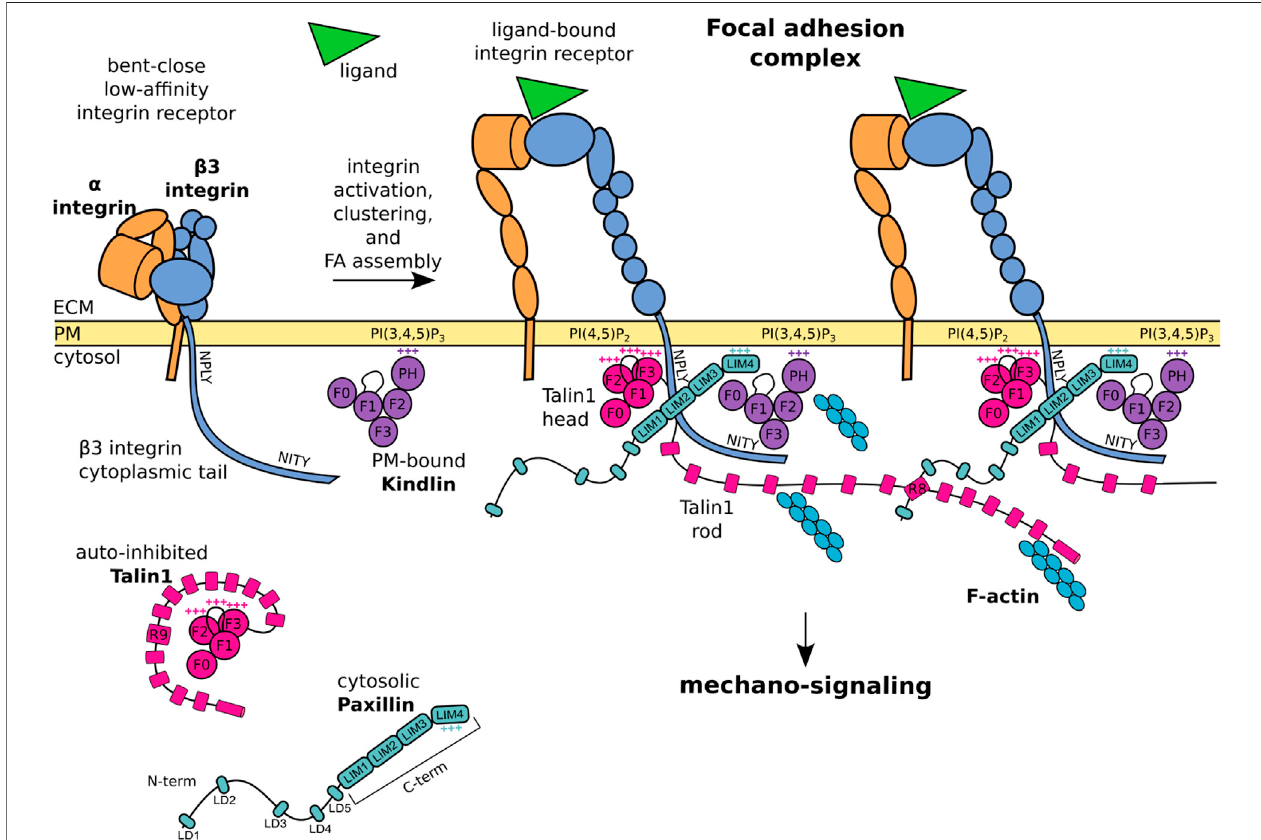
FIGURE 1 | Schematic representation of core FA proteins and their interactions. The β 3 integrin subunit is composed of an extracellular domain, a transmembrane domain, and a C-terminal cytoplasmic tail presenting the membrane proximal NPLY talin-binding and membrane distal NITY kindlin-binding sites. The heterodimericintegrinreceptorinabent-closelow-af fi nityconformation(left)switchestoanextended-openhigh-af fi nitystateandbindsligandsandintracellularproteins (right). Talin1 consists of a globular head, an unstructured linker, and a C-terminal rod domain which intramolecularly interacts with the head domain to keep cytosolic talin1 auto-inhibited. Upon integrin activation, the talin1 F2 domain binds to membrane phospholipid PI(4,5)P 2 , the talin F3 subdomain to the membrane proximalNPLYmotifinthe β 3integrincytoplasmictail,andthetalinrodengagestheF-actinnetwork. Kindlin issimilarlyorganizedtotalin-headbutwiththeadditionofa PH domain inserted within the F2 domain which recognizes membrane phosphoinositides, while the F3 domain binds to the membrane-distal NITY motif in the β 3 integrin cytoplasmic tail. The paxillin amino-terminal half presents fi ve short LD motifs and is followed by the carboxyl-terminal half composed of four LIM domains. The paxillin N-terminal LD1 and LD2 interact with the talin1 R8 domain, the LIM domains point towards the membrane proximal region, the positively charged LIM4 domain interacts with kindlin and the plasma membrane. One of the paxillin LIM domain could recognize the Y presented by the NPLY motif. +++ indicates positively charged regions. For representative purposes, the β 3 integrin tail is outsized and some protein domains are simpli fi ed or omitted for clarity.